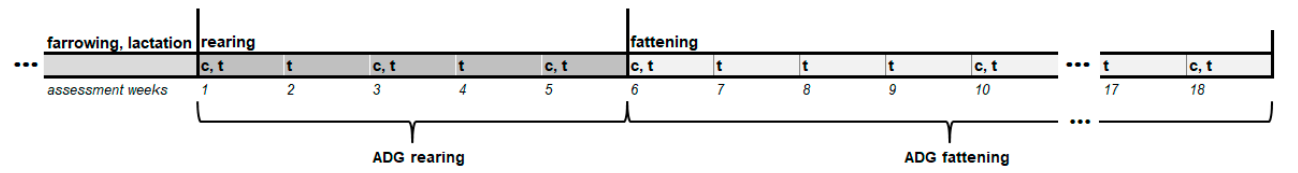
Figure 2. Timeline for the assessed and analyzed parameters over the 18 assessment weeks (c: complete assessment of skin lesions, ear lesions and losses, lameness and manure on the body; t: assessment of tail lesions and losses; ADG: calculated average daily gain).